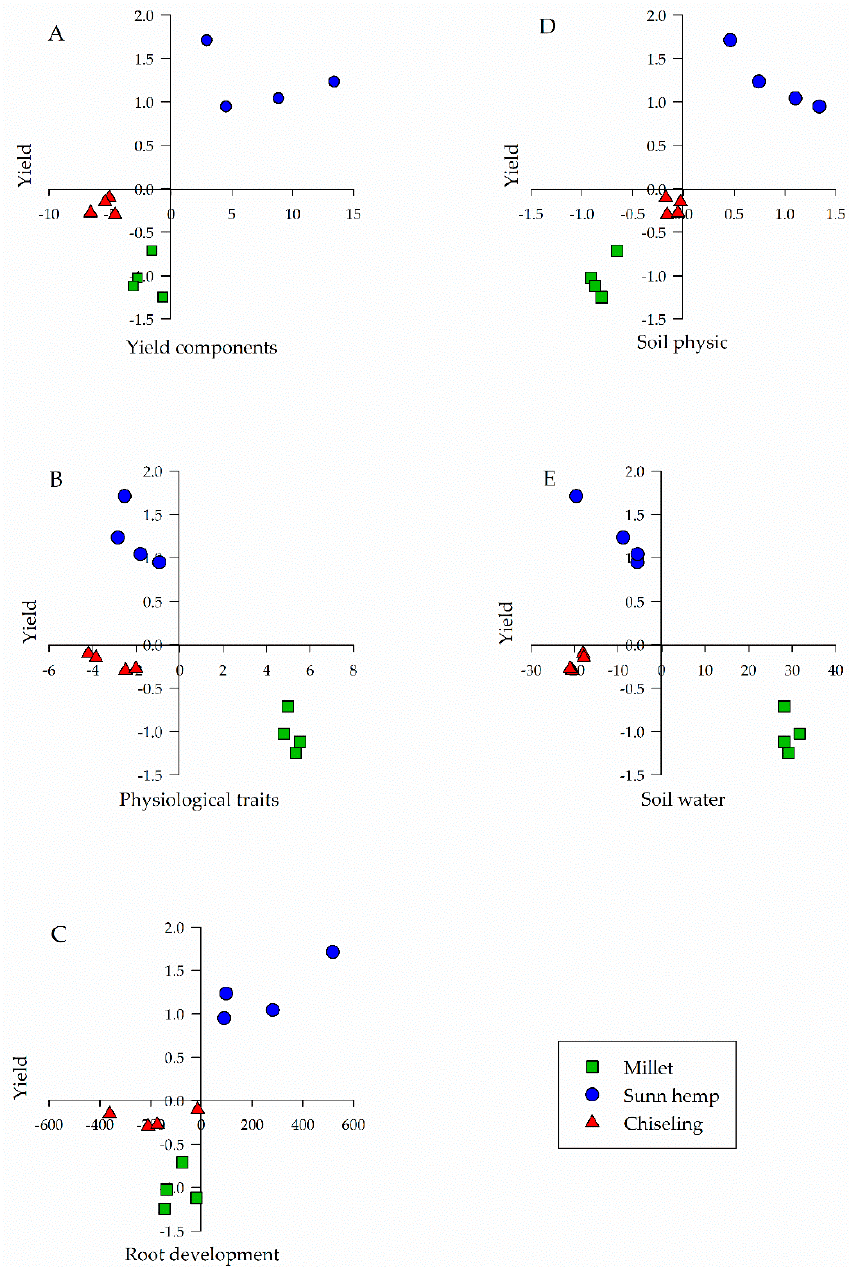
Figure 2. Dispersion of observations in principal component 1 of yield components ( A ), physiological traits ( B ), root development ( C ), soil physics ( D ), and soil water ( E ) variables. The highest soybean yield, observed in crop rotation with sunn hemp during the spring season (3.900 kg ha − 1 ), was associated with plants with a greater number of pods and with greater thousand grains weight (Figure 2A); greater leaf area index, water content and water potential in the leaf (Figure 2B); greater root dry matter (Figure 2C) and soil penetration resistance (Figure 2D); and greater infiltration and the basic rate of water infiltration into the soil (Figure